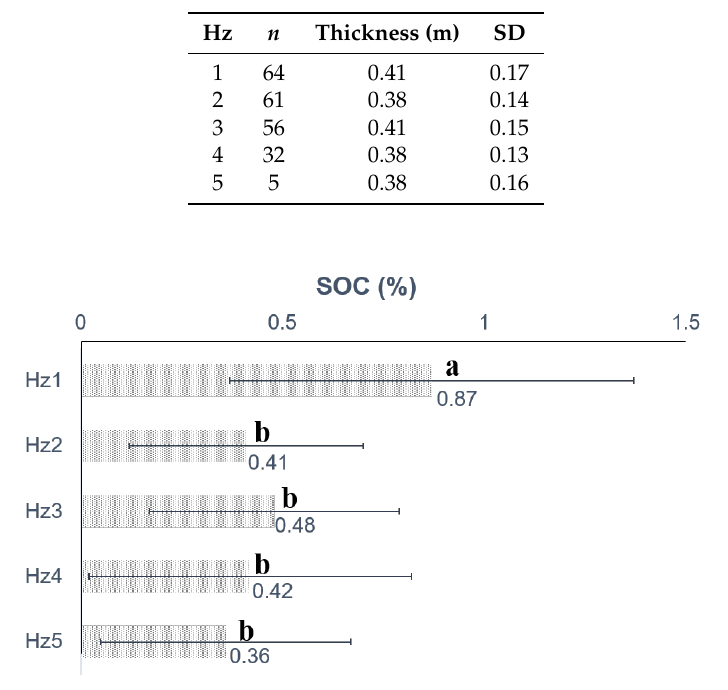
Figure 3. SOC in%. Different letters indicate significant differences according to the Kruskal–Wallis test ( p < 0.05). Horizon (Hz).